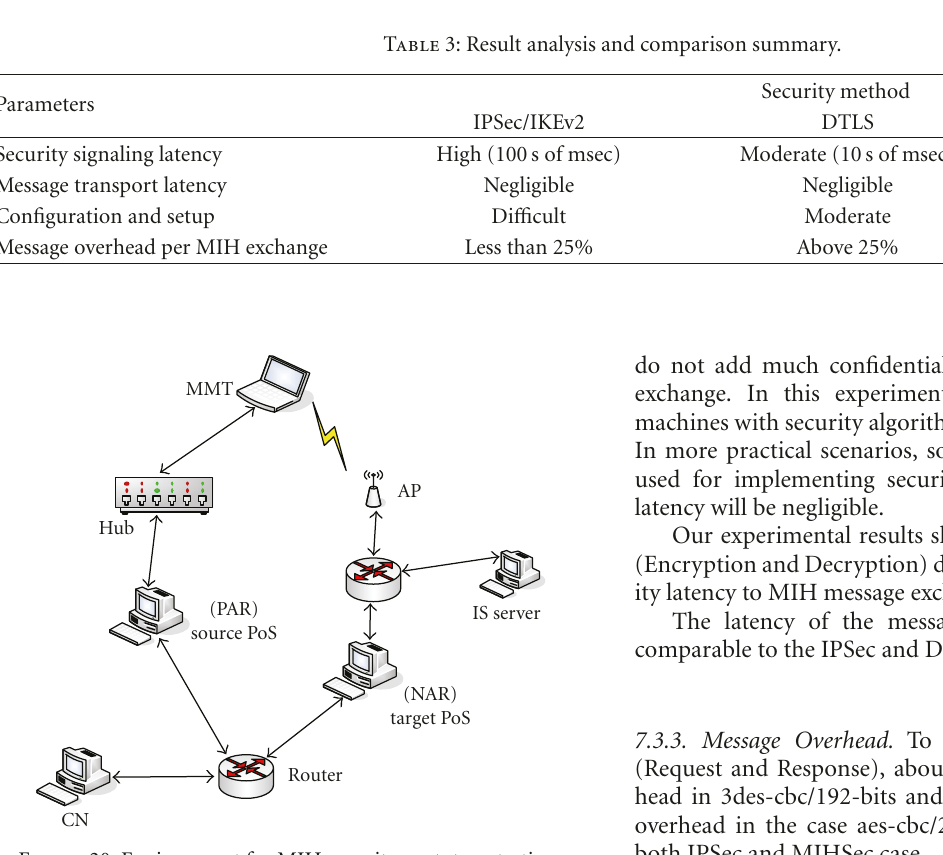
Figure 20: Environment for MIH security prototype